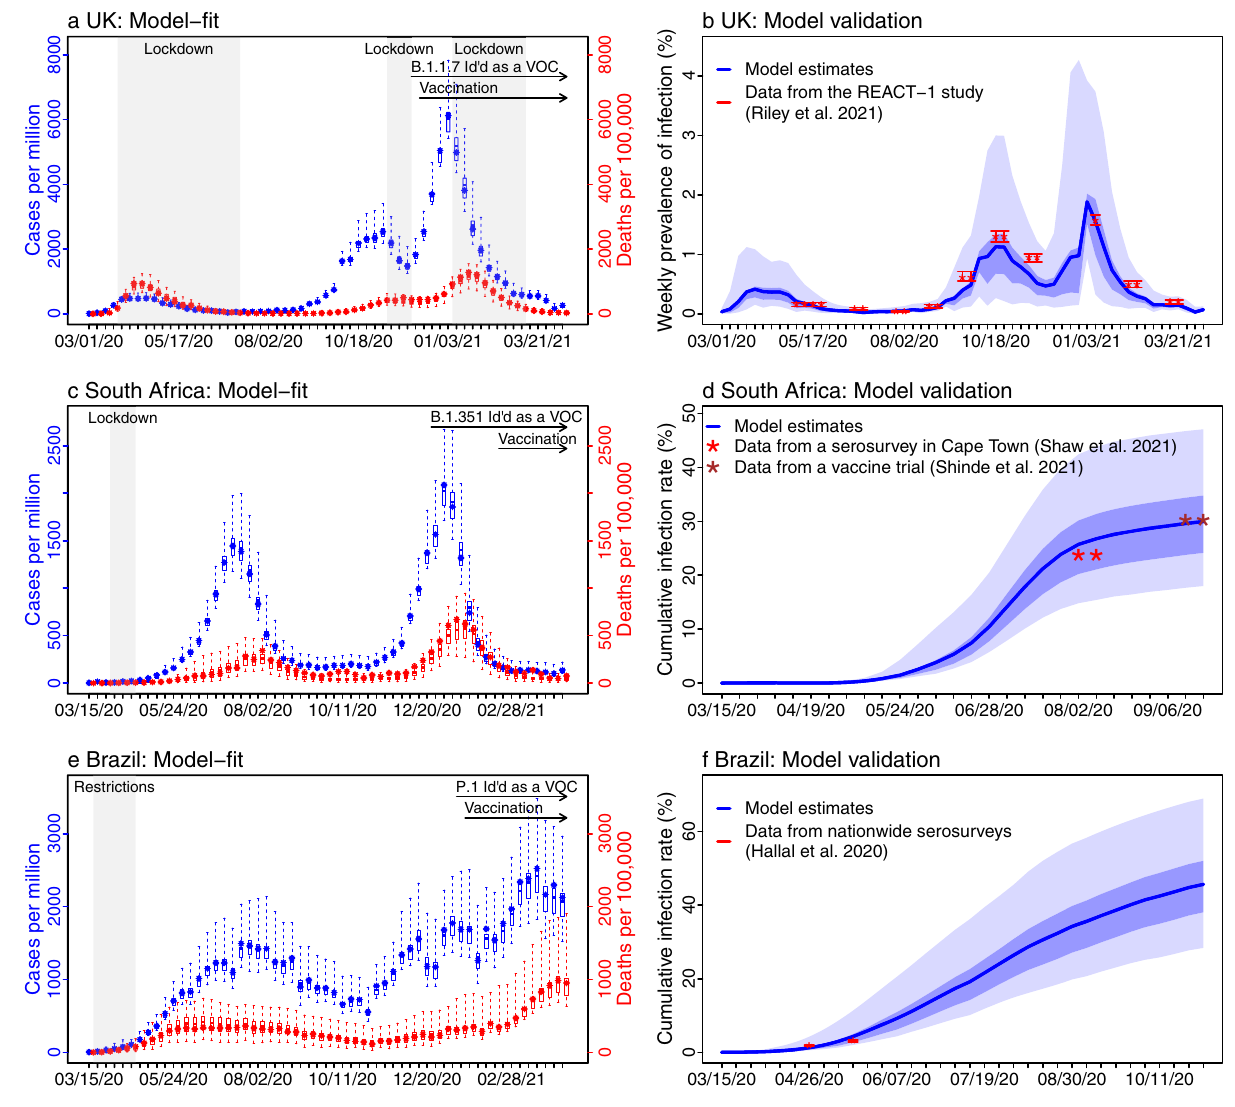
Fig. 2 Model-inference system fi t to data for the three countries and validation using independent datasets. The left column shows the model fi t to reported weekly case and mortality data for the UK ( a ), South Africa ( c ), and Brazil ( e ). Dots show the weekly number of cases (in blue) and deaths (in red) per 1 million persons; boxes (middle bar = mean; edges = 50% CrIs) and whiskers (95% CrIs) show the corresponding model estimates. Gray shaded boxes indicate the timing of lockdowns or key periods of restricted activity; horizontal arrows indicate the timing of variant identi fi cation and vaccination rollout. The right column compares available, independent measurements to corresponding model estimates. Red dots and error bars show measured prevalence over 10 periods of time from the REACT-1 study for the UK ( b ), cumulative infection rates from two serology studies in South Africa ( d ), and cumulative infection rates from two nationwide household serosurveys in Brazil ( f ). Blue lines and surrounding areas show model-estimated mean, 50% (dark) and 95% (light) CrIs. Model estimates (mean, 50% and 95% CrIs) are summarized over n = 100 model-inference runs (500 model replica each, totaling 50,000 model